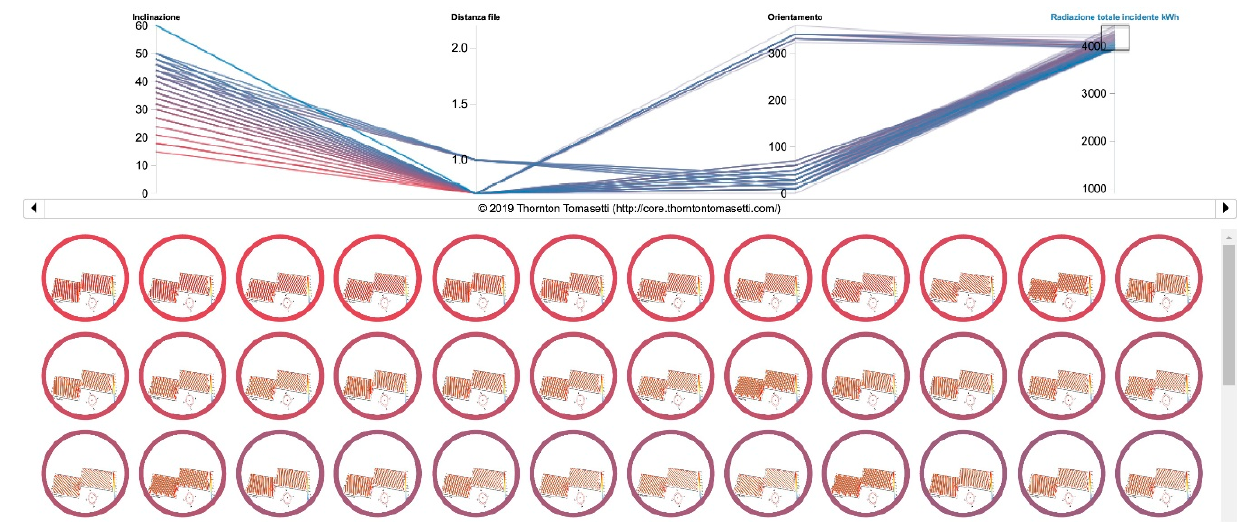
Figure 6. DesignExplorer interface for the visualization and filtering of solutions (filters in the case are the following: tilt angle, rows distance, orientation, and solar incident radiation).